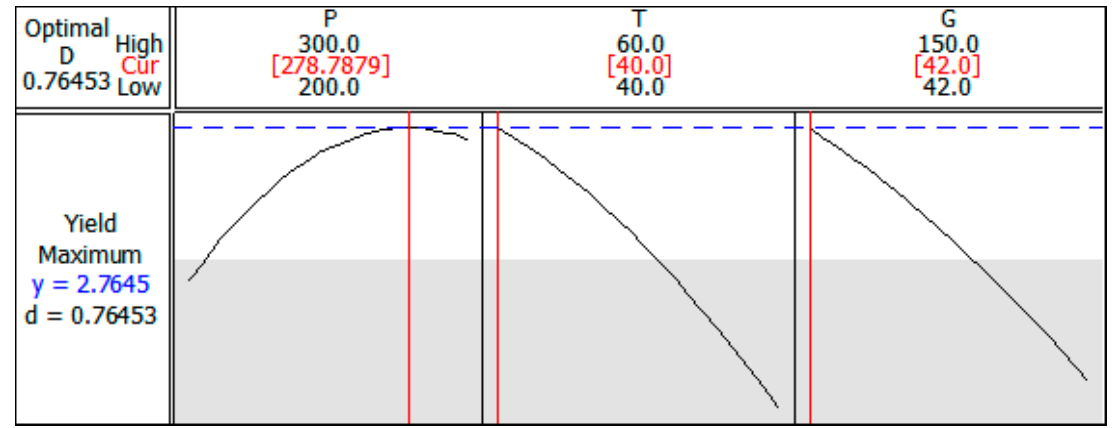
Figure 3. Process parameters optimized to maximum yield of p -anisic acid.